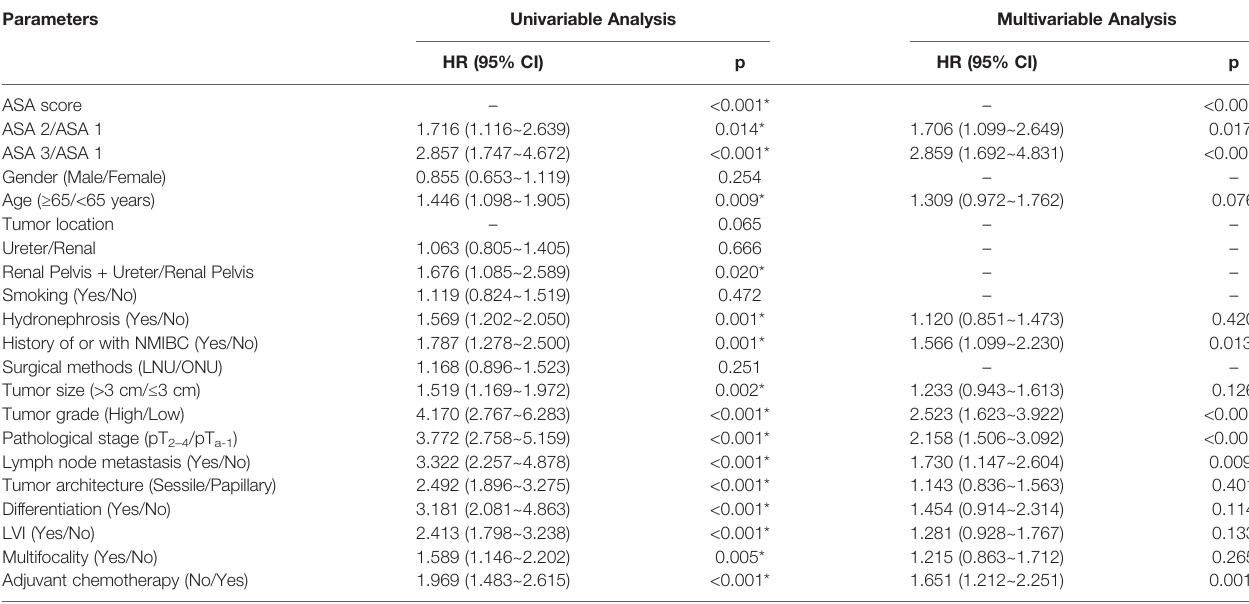
ASA, American Society of Anesthesiologists; HR, hazard ratio; LNU, laparoscopic nephroureterectomy; LVI, lymphovascular invasion; MFS, metastasis-free survival; NMIBC, non-muscle invasive bladder cancer; ONU, open nephroureterectomy. *p < 0.05.